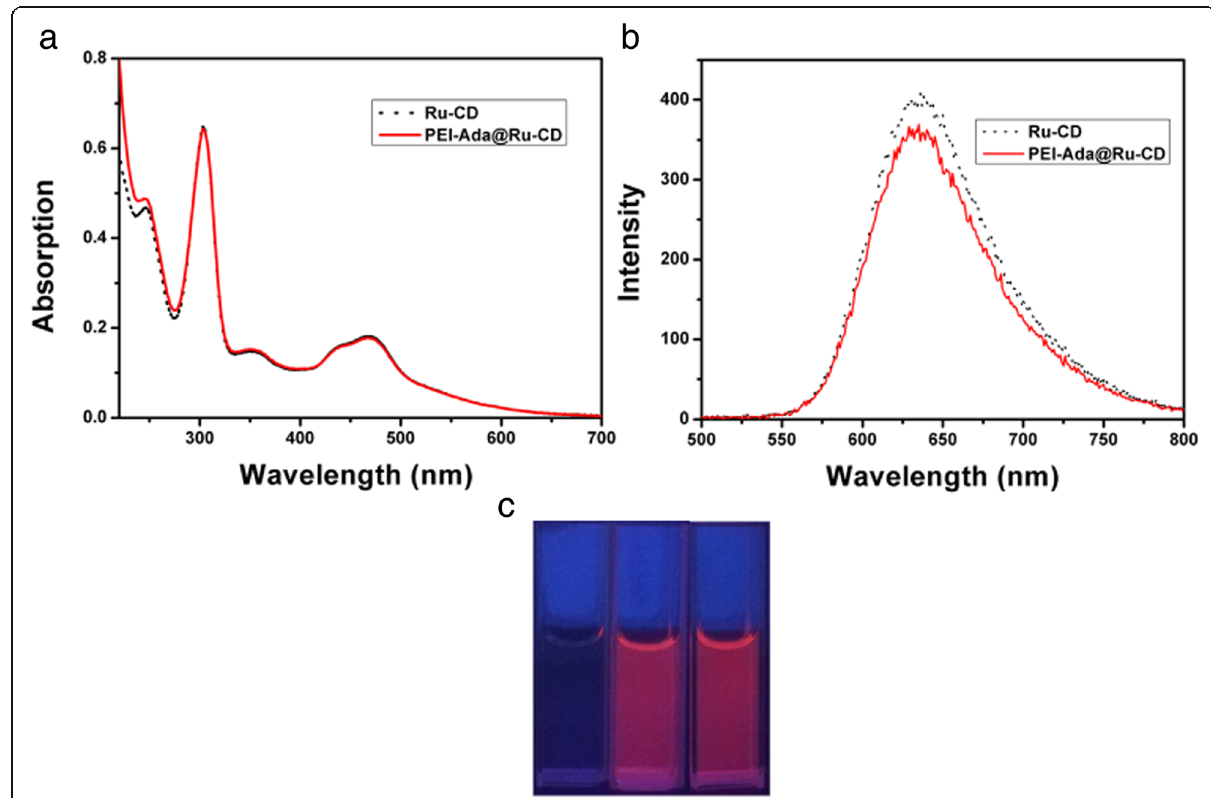
Fig. 1 a Absorption and b emission spectra of Ru-CD and PEI-Ada@Ru-CD in water (10 μ M). c Luminescence colors of the solutions of PEI-Ada (left), Ru-CD (middle), and PEI-Ada@Ru-CD (right) under a 365 nm